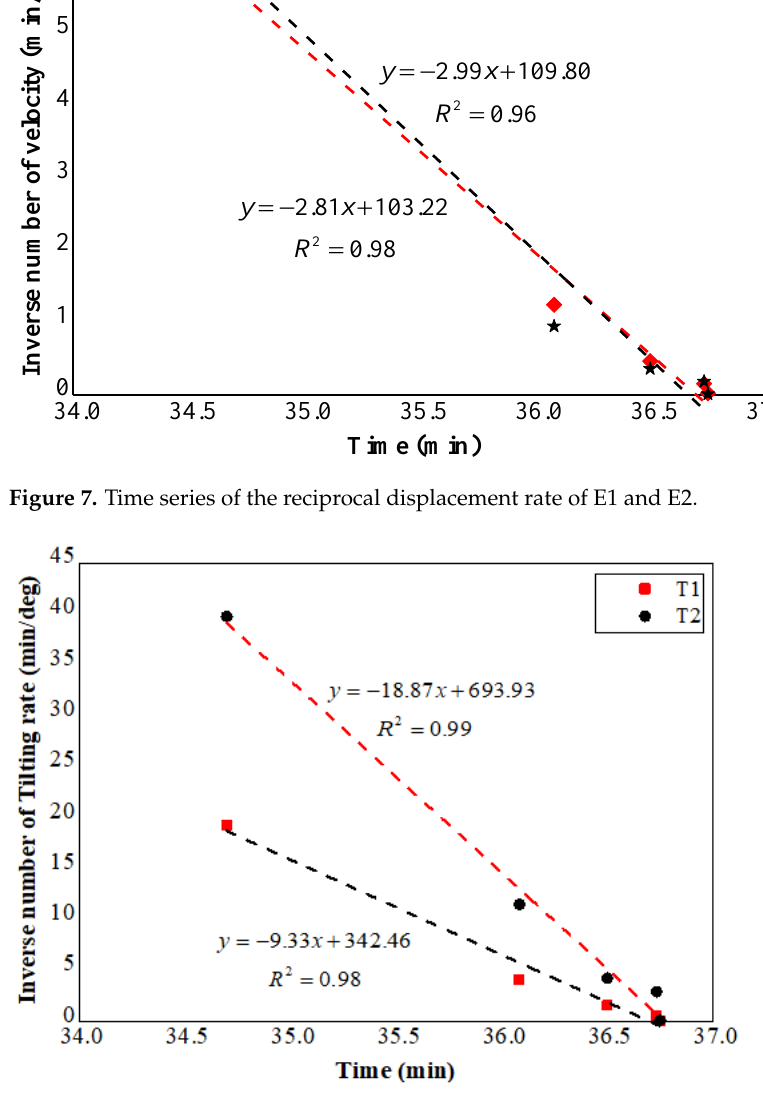
Figure 8. Time series of the reciprocal tilting rate of T1 and T2.